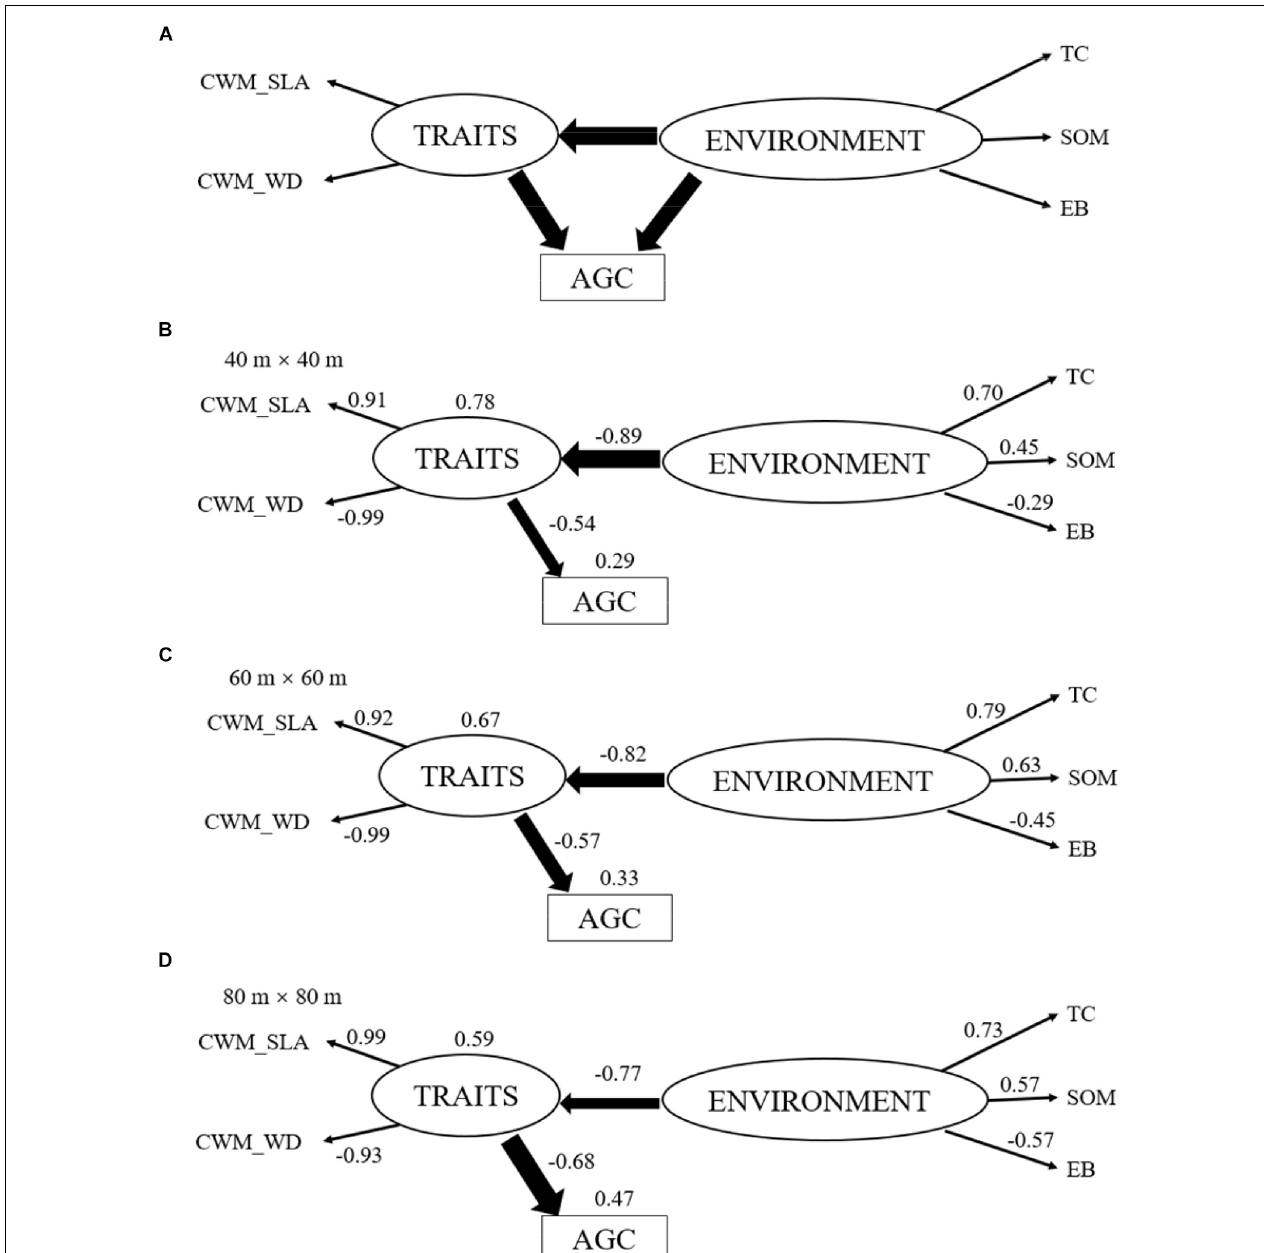
FIGURE 1 | Hypothesized structural equation model (A) . This model provides a multivariate perspective about how abiotic site conditions [ENVIRONMENT, including terrain convexity (TC), soil organic matter (SOM) and exchangeable base (EB)] and functional traits at community level [TRAITS, including specific leaf area and wood density at community level (CWM_SLA and CWM_WD)] interact to influence aboveground carbon stock (AGC). One-headed arrows represent the hypothesized causal relationships between variables. The final structural equation models at 40 m × 40 m scale (B) , 60 m × 60 m scale (C) , 80 m × 80 m scale (D) . The value nearby arrows represents for the standardized regression path coefficient ( P < 0.05) and values at the upper right corner of variables represent for the percentage of variance explained by the model. Arrow width indicates the strength of the relationship. The paths of ENVIRONMENT to AGC at these three scales were deleted, due to the non-significant relationship ( P >